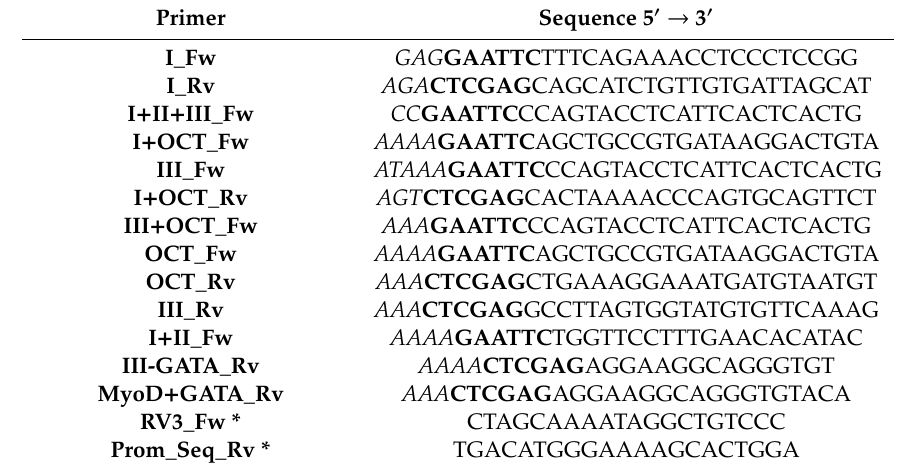
Table 1. List of the primers used to amplify the sequences within CNS2 for further cloning and sequencing. The sequence in italics indicates the extra bases that allow restriction enzymes to cut; bold sequences indicate XhoI and EcoRI target sequences; plain text indicates the CNS2 sequence.